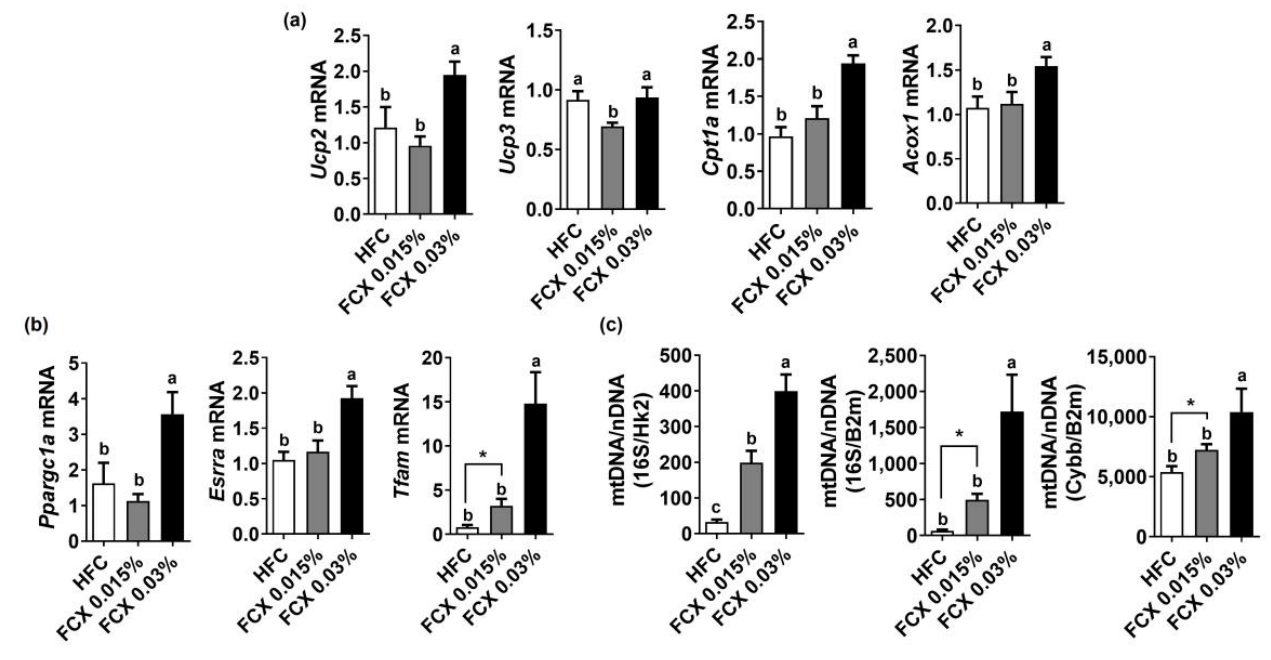
Figure 5. Effect of FCX on the expression of energy-utilization-related genes in the soleus muscle of DIO mice fed HFC, FCX 0.015%, or FCX 0.03% for 12 weeks. The expression of genes related to ( a ) β -oxidation and ( b ) mitochondrial biogenesis in soleus muscle. ( c ) Mitochondria DNA copy number in soleus muscle. n = 6–11 per group. Mean ± SEM. Bars without sharing the same letter are significantly different ( p < 0.05). * p < 0.05 between two